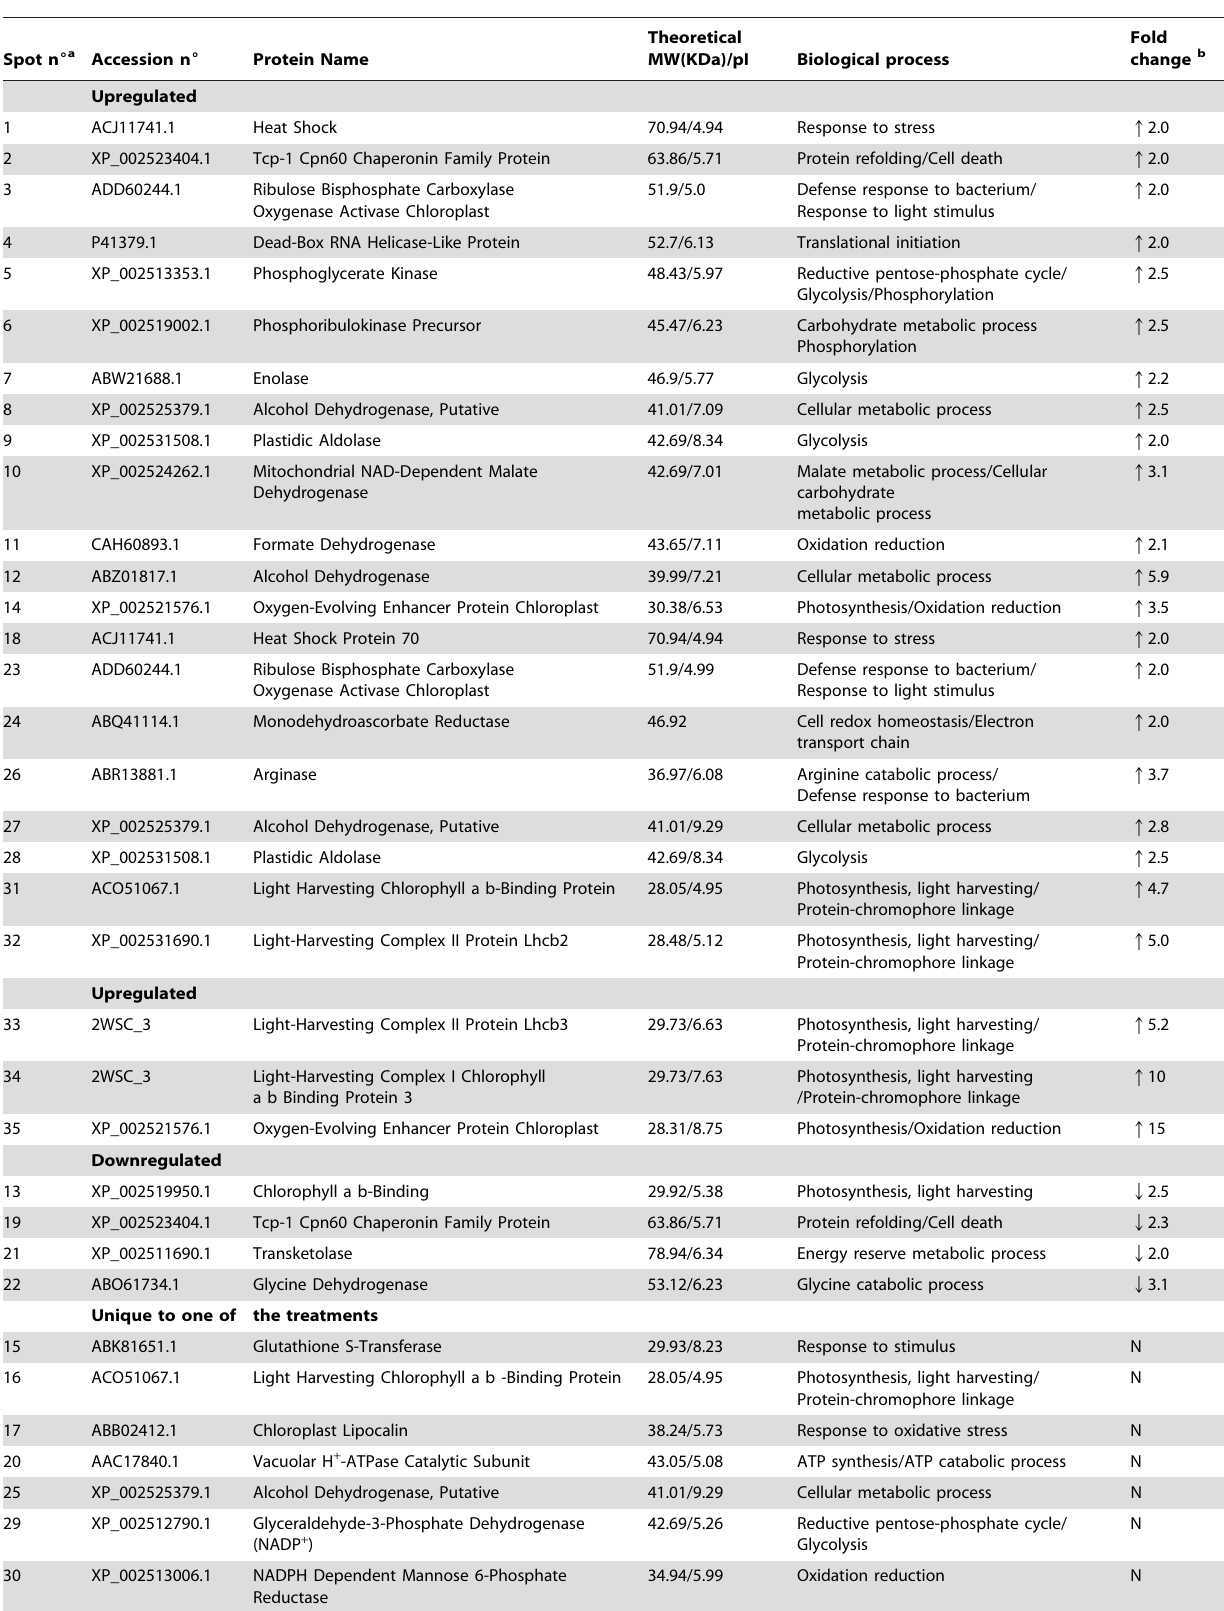
Table 1. Proteins from leaves of TSA-792 and TSH-774 clonal genotypes of Theobroma cacao identified by mass